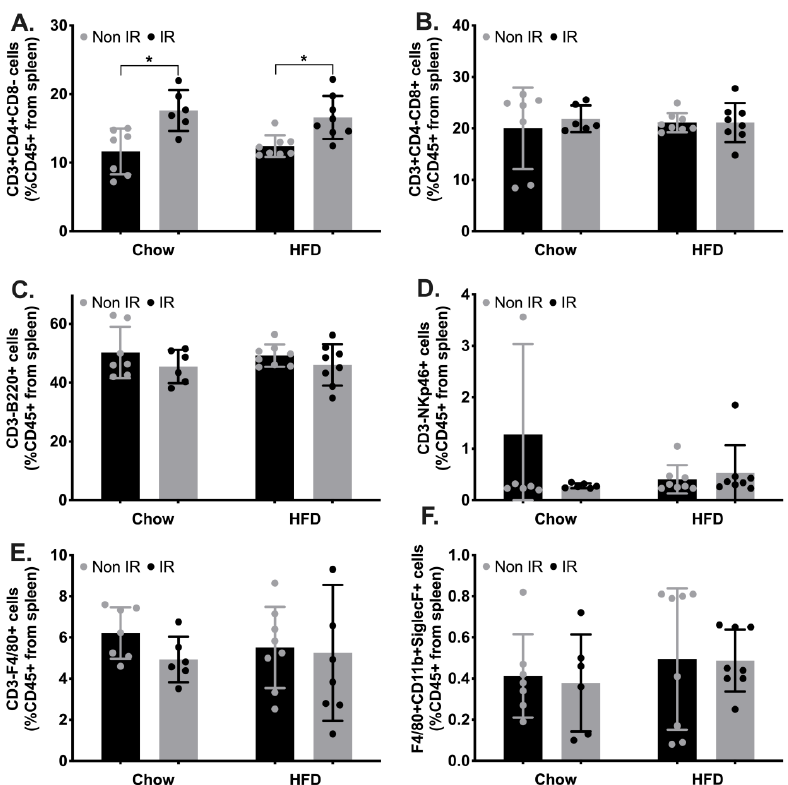
Figure 2. Immune cell profiling in the spleen. ( A ). T helper cells (CD45+CD3+CD4+CD8-). ( B ). T cytotoxic cells (CD45+CD3+CD4-CD8+). ( C ). B lymphocytes (CD45+CD3-B220+). ( D ). Natural killer cells (CD45+CD3-NKp46+). ( E ). Macrophages (CD45+F4/80+CD3-). ( F ). Eosinophils (CD45+F4/80+CD11b+SiglecF+). * — Interaction effect between irradiation (IRR) and high-fat diet (HFD) with significant difference between the two groups.